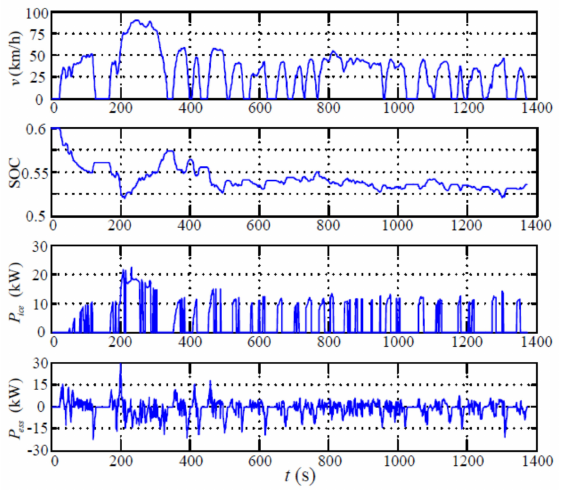
Figure 19. Simulink model for the proposed optimization algorithm [21]. Figure 20 below represents the simulation result using SQPIS.